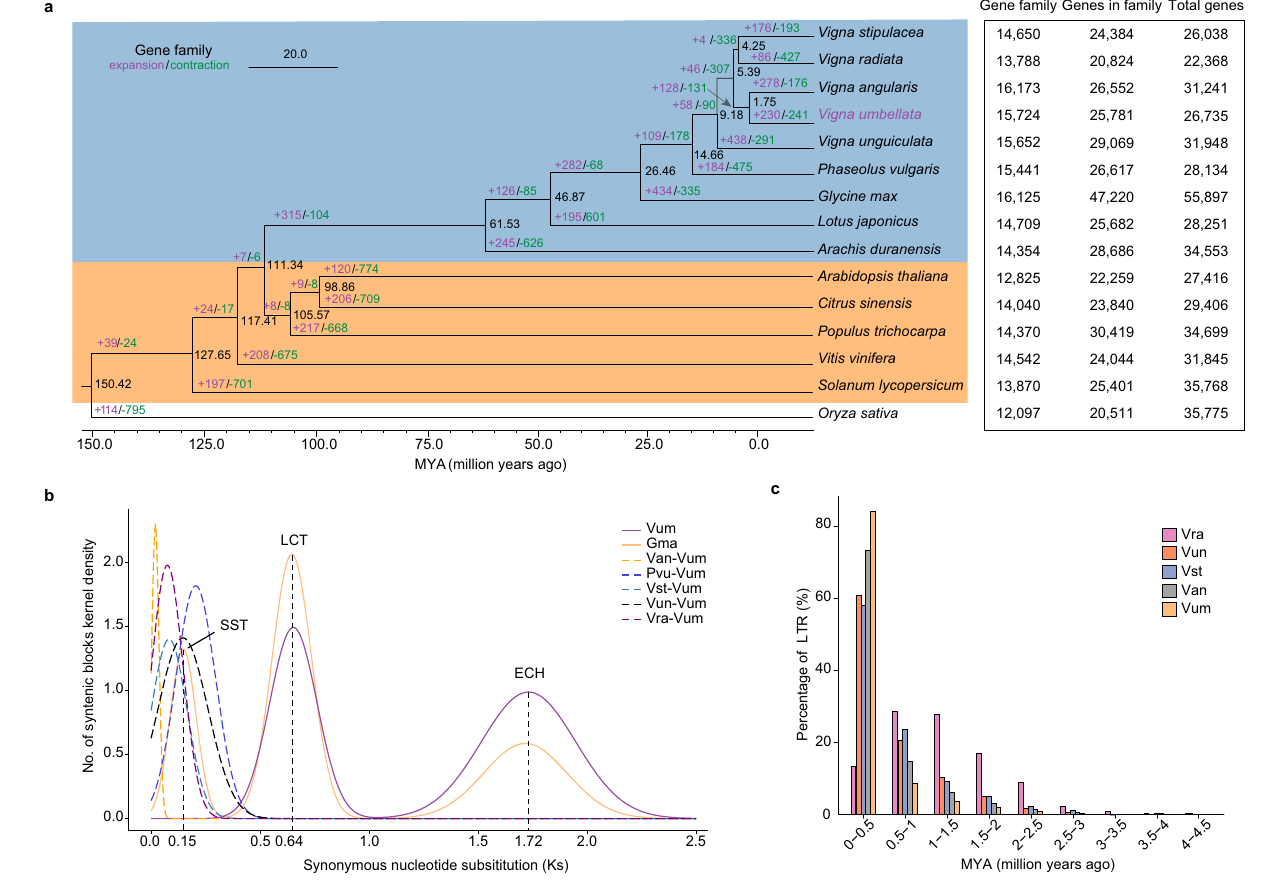
Fig. 2 | Phylogenetic position and comparative genomics analyses. a Genome evolution and gene family characteristics of Vigna umbellata (rice bean) and 13 other dicot species using the monocot plant Oryza sativa (rice) as an out-group. This tree was generated using 334 single-copy ortholog families. Black numerical values beside each node show the estimated divergence time of each node (MYA, million years ago) in the phylogenetic tree shown on the left. Blue and orange backgrounds represent Leguminosae and non- Leguminosae species, respectively. Thenumberofgenefamilies,genesinthefamily,andthetotalnumberofgenesare